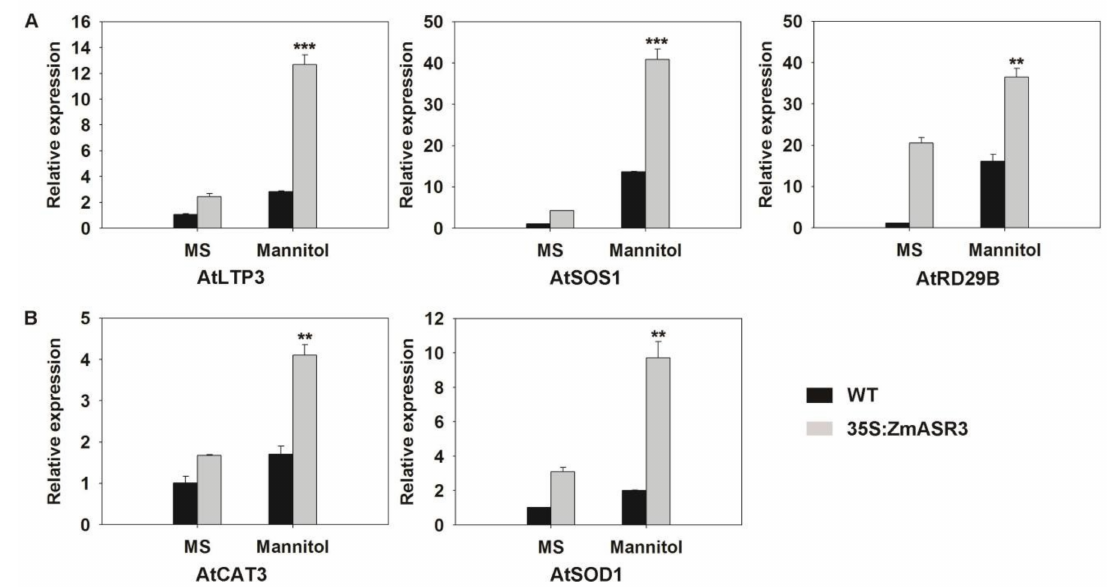
Figure 8. Analysis of expression levels of ( A ) stress-responsive and ( B ) reactive oxygen species (ROS)-related genes in the WT and transgenic line under control and osmotic stress conditions. The experiment was repeated three times with three biological repeats. Vertical bars indicate means ± S.E. ( n ≥ 3). Significant di ff erences: ** p < 0.01; *** p <